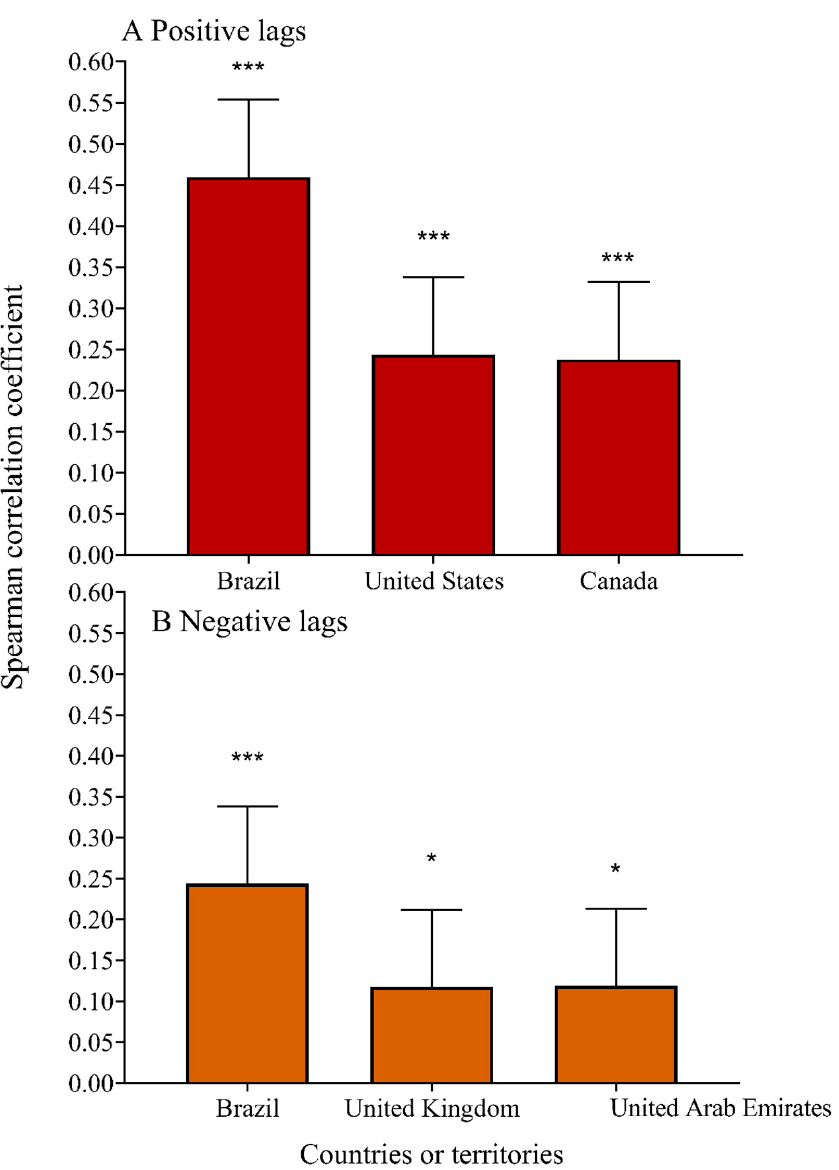
Figure 4. Time-lag correlations of online search activity and daily new cases in the top three countries or territories by positive and negative lags. * p < 0.05; *** p < 0.001.